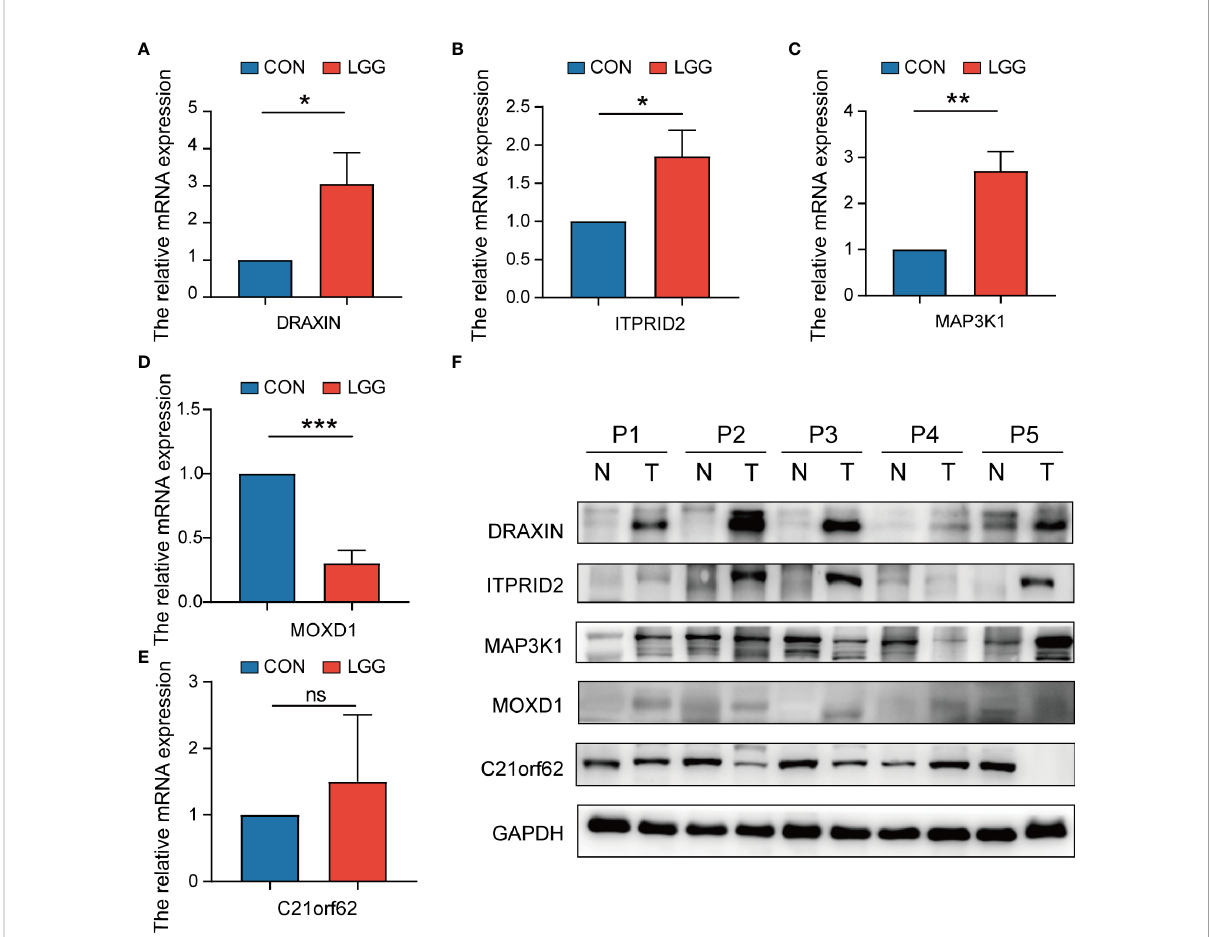
FIGURE 14 The expressions of fi ve signature genes were validated by quantitative real-time PCR (qRT-PCR) and Western blotting (WB). (A – E) Expression of genes at the mRNA level by qRT-PCR. (F) Expression of genes at the protein level by WB. qRT-PCR, quantitative real-time PCR; WB,